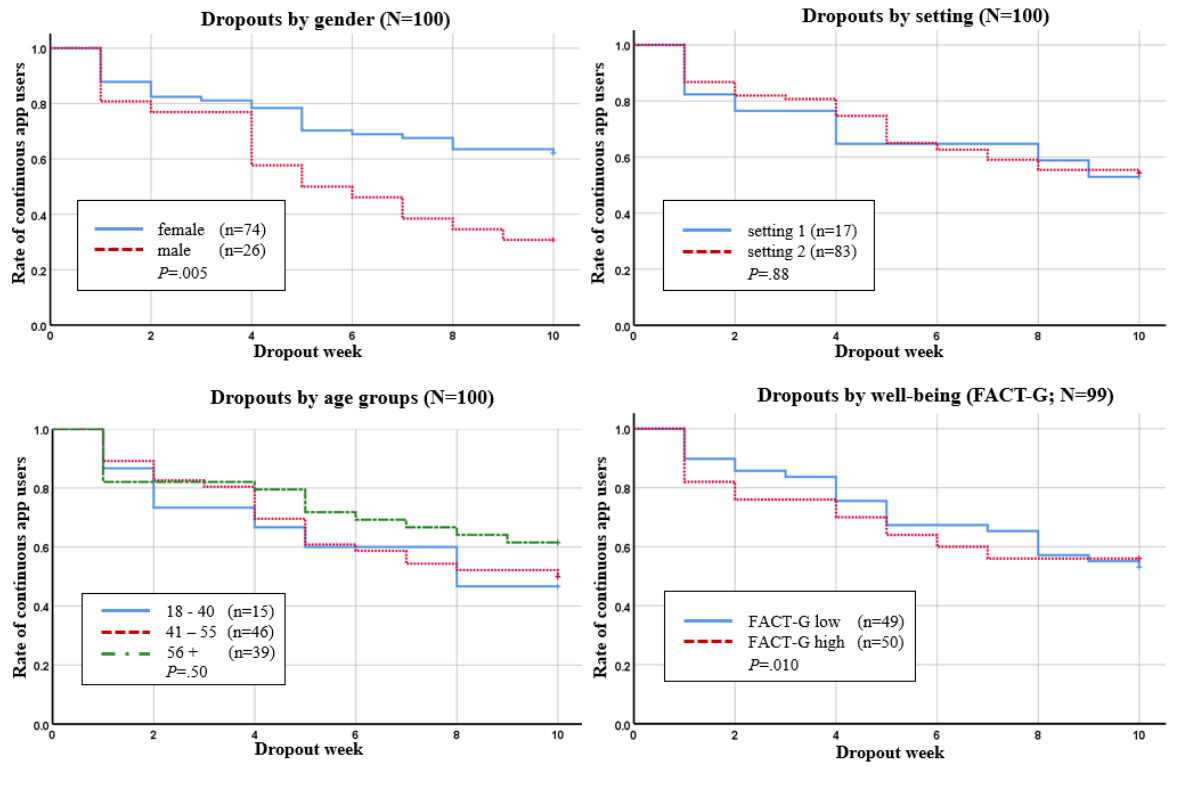
Figure 5. Kaplan-Meier survival curves for continuous app users by gender, setting, age groups and well-being. FACT-G: Functional Assessment of Cancer Therapy-General.